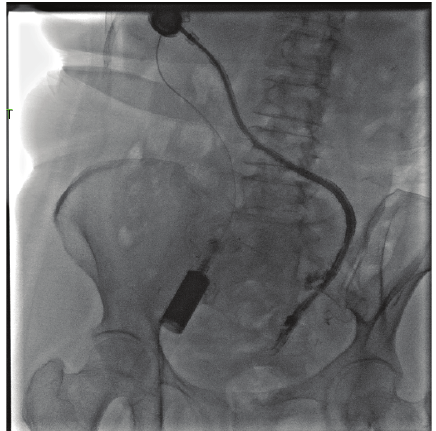
Figure 1: Initially, a fluoroscopic examination of the peritoneal catheter was performed because the catheter was not functioning well. The images show contrast flowing around the catheter with little spillage into the pelvis, consistent with a fibrin sheath.